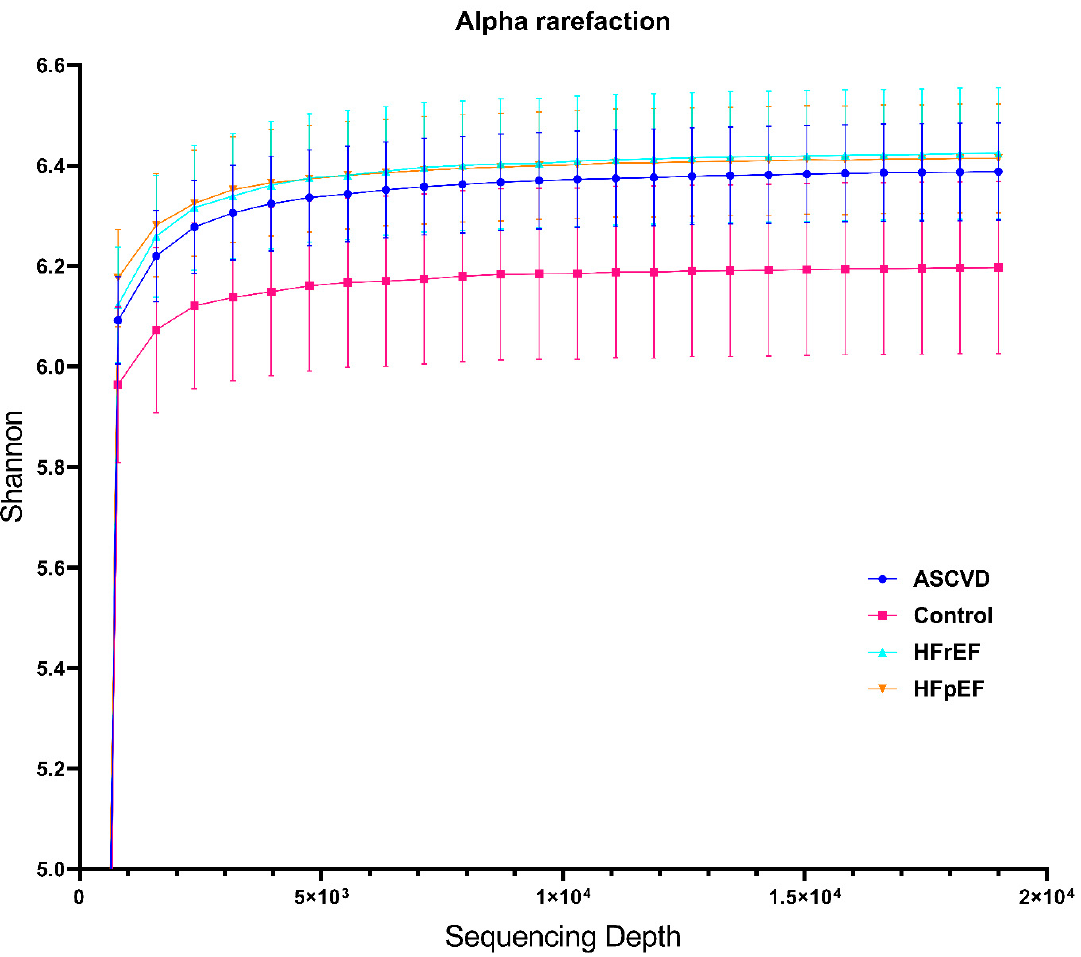
Figure 1. Rarefaction curves showing Shannon diversity index at various sequencing depths.